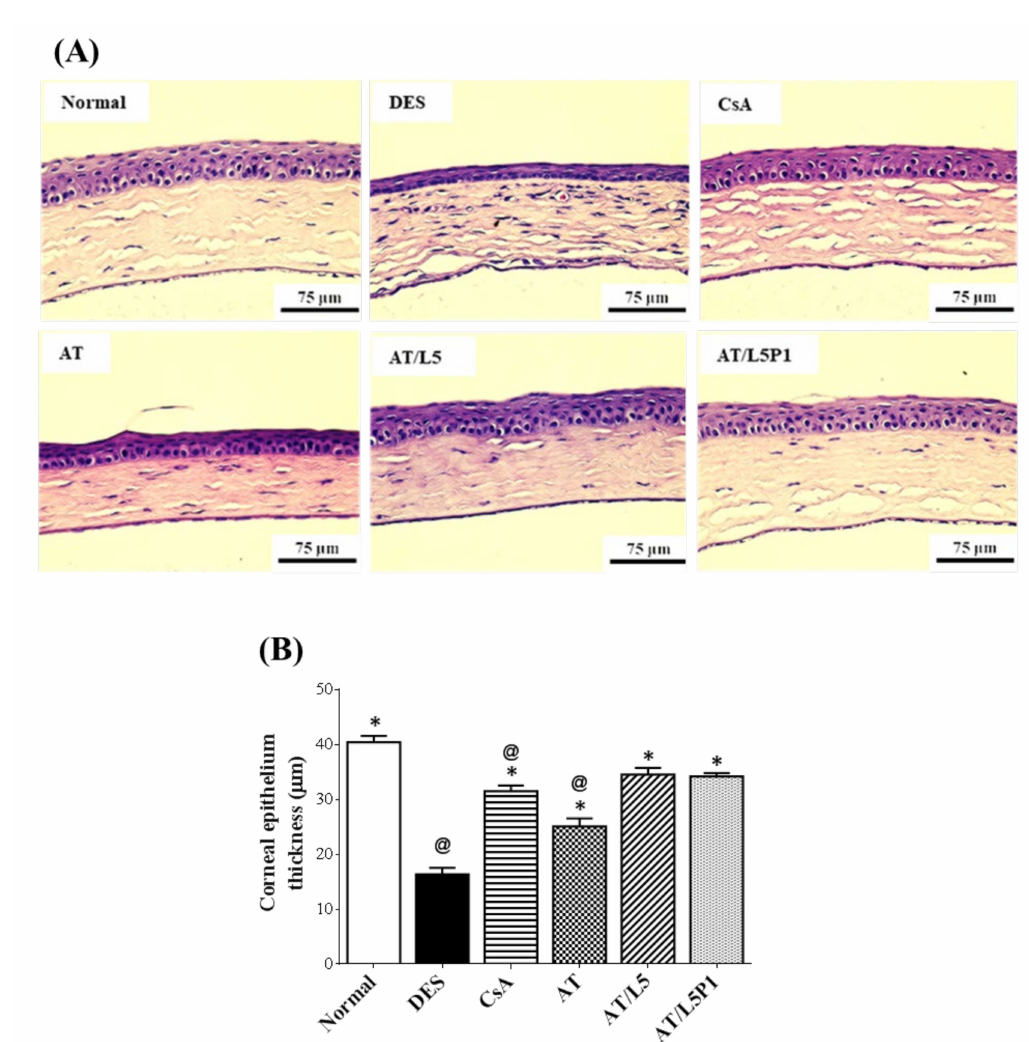
Figure 7. Effect of the combinatorial treatment with AT and lutein on the histopathology of BAC-induced dry eye syndrome in mice. ( A ) Hematoxylin and eosin (H&E) staining of corneal sections from the eyes of mice in various groups (Scale bar = 75 µ m). ( B ) Quantification of corneal epithelial thickness. Data were analyzed using one-way ANOVA and are expressed as the mean ± standard deviation (SD); n = 5, (@ p < 0.05 compared with the control group, * p < 0.05, compared with the DES